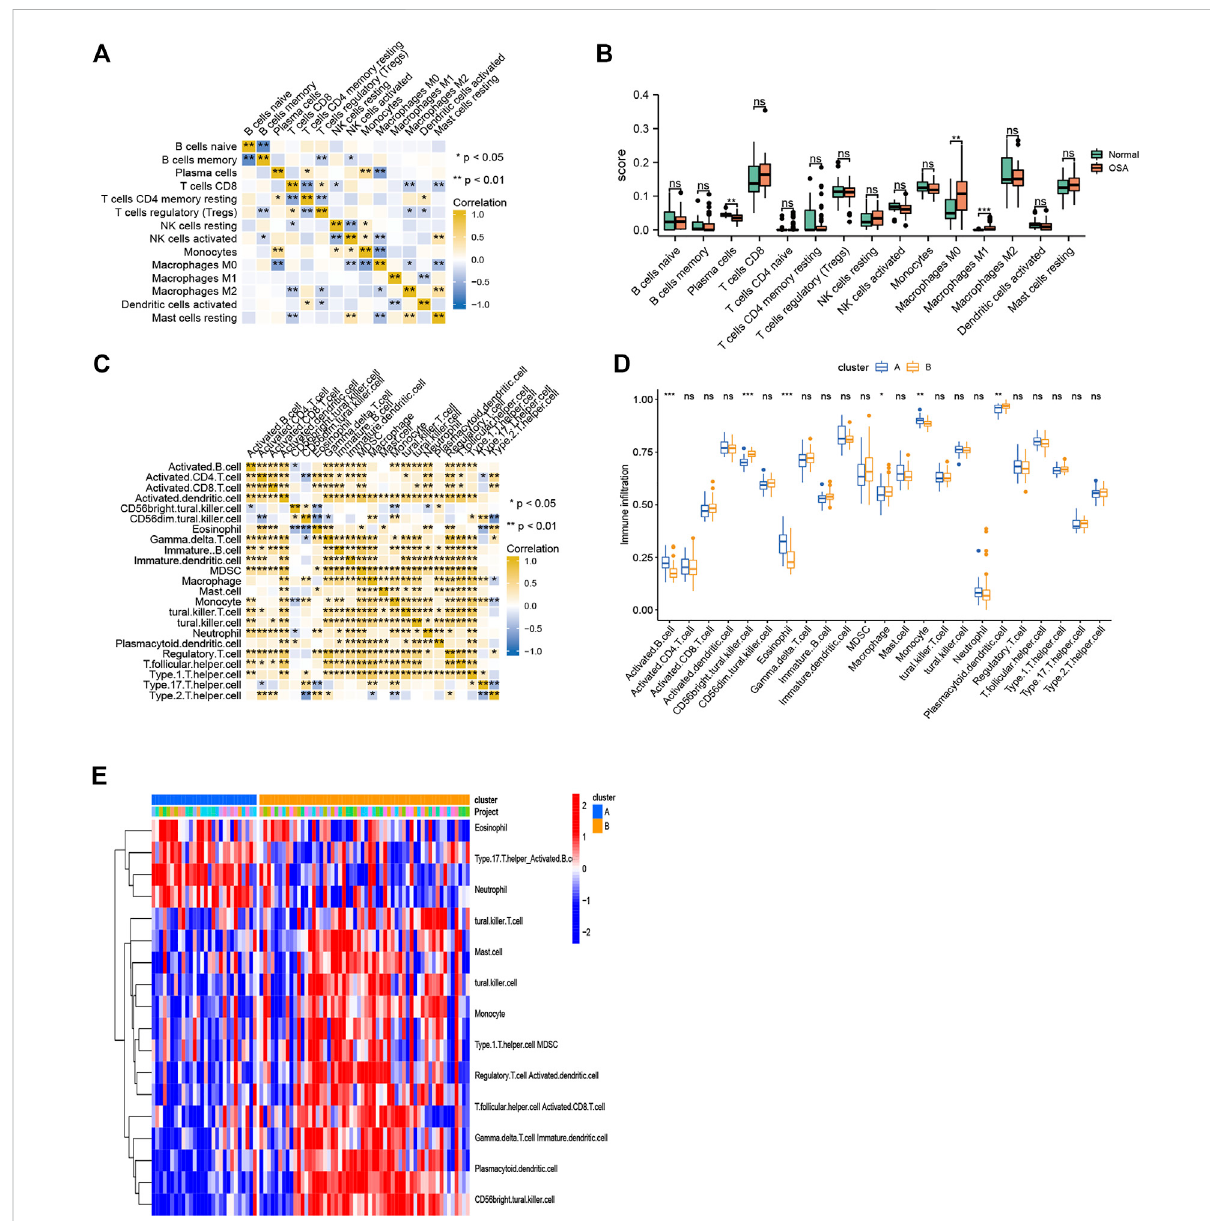
FIGURE 9 Immune cell in fi ltration. (A) Heatmap of correlations among 15 in fi ltrating immune cells, as analyzed by CIBERSORT. (B) Boxplot of differences in 15 in fi ltrating immune cells between OSA and control samples, as analyzed by CIBERSORT. (C) Heatmap of correlations among 23 in fi ltrating immune cells, as analyzed by ssGSEA. (D) Boxplot of differences in 23 in fi ltrating immune cells between clusters A and B, as analyzed by ssGSEA. (E) Heatmap of the differences in immune cell in fi ltration (based on ssGSEA between clusters A and